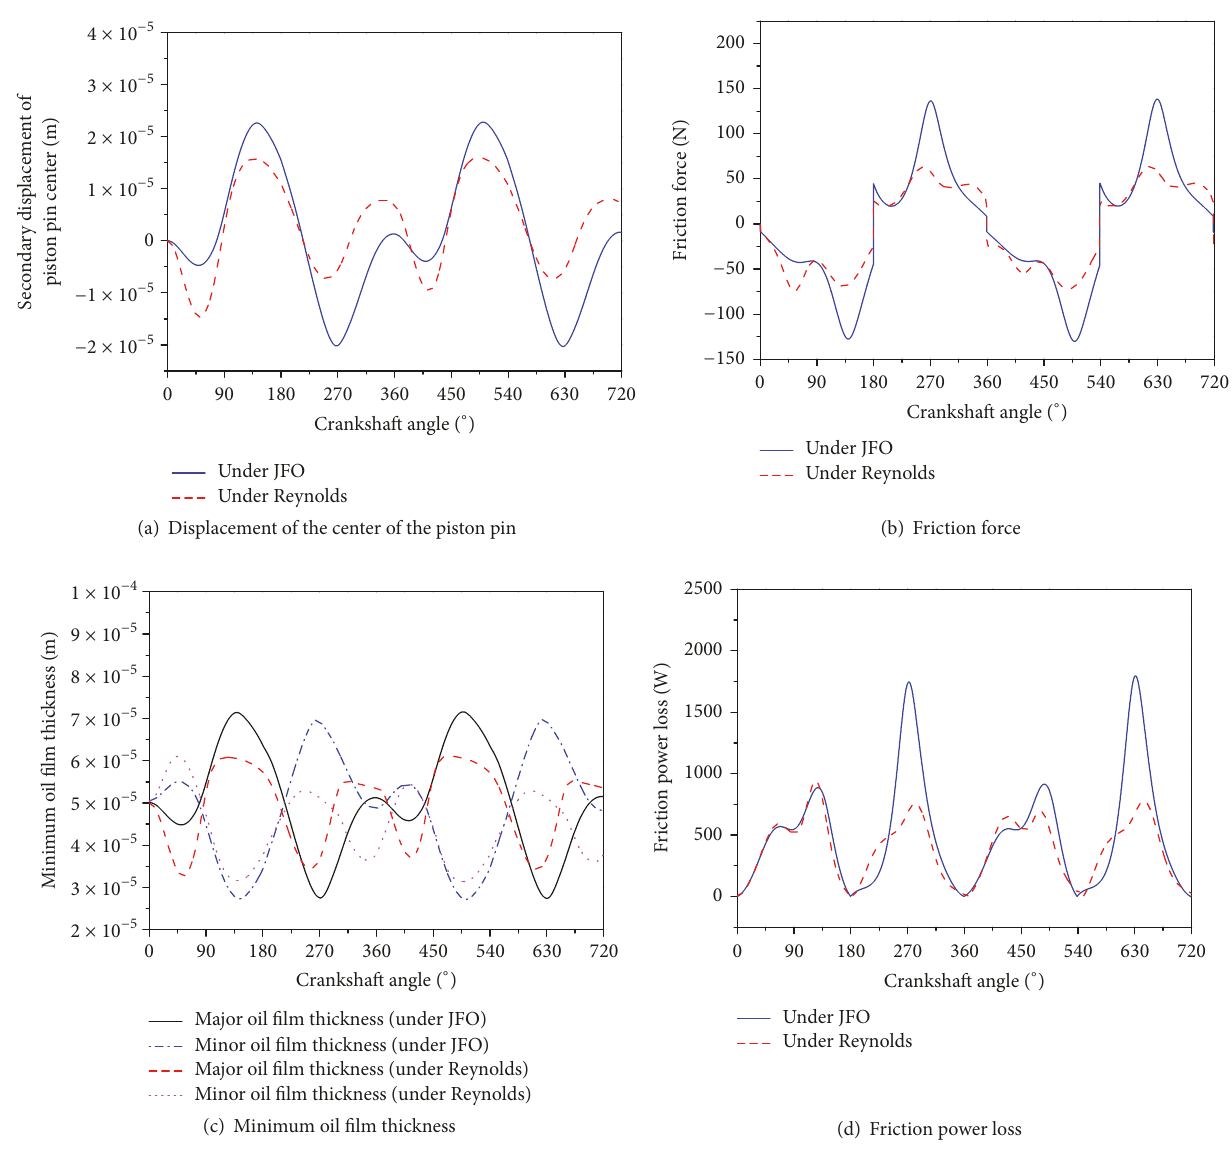
Figure 9: Comparison of secondary motions of the piston under the Reynolds and JFO boundary